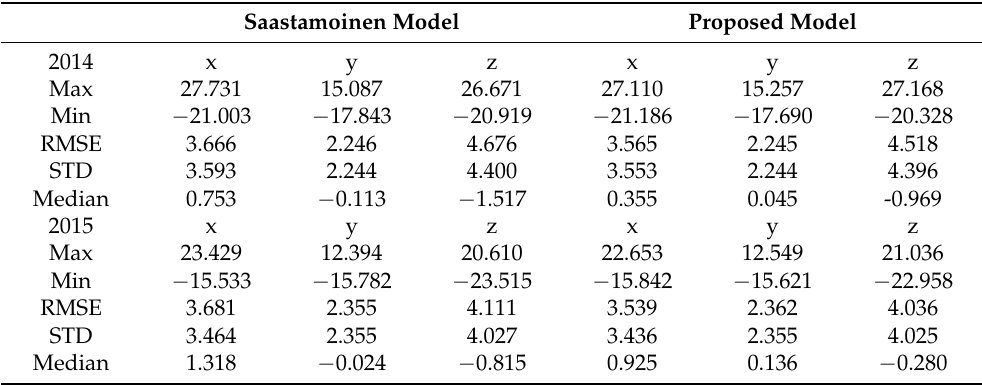
Table 4. Comparison of RMSE, STD, range, and median values for the ˇCakovec GNSS location obtained using the Saastamoinen model and the proposed model (in